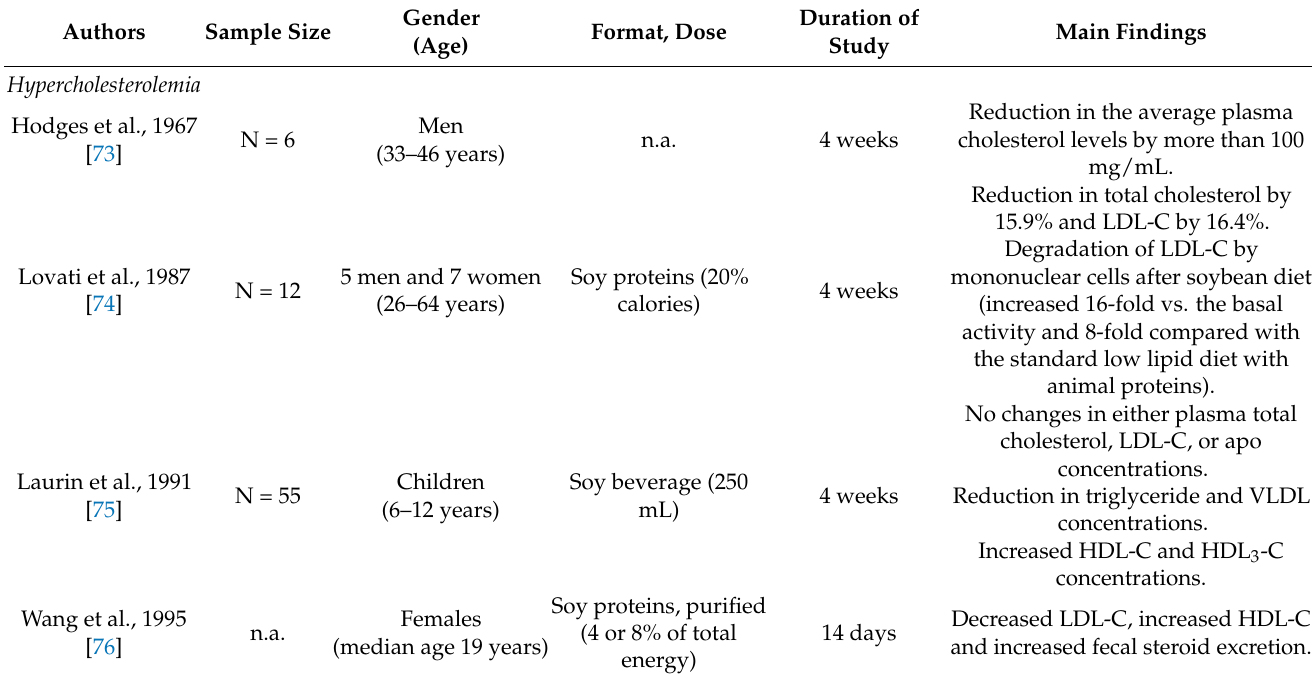
Table 3. Main clinical controlled trials involving intake of soy